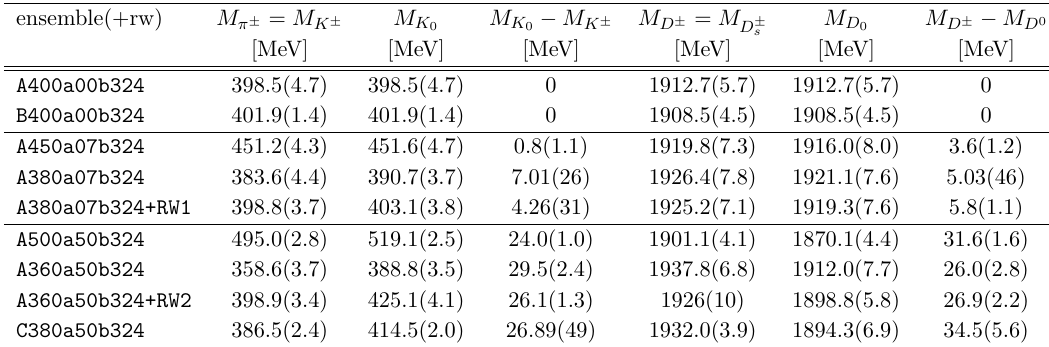
Table 5 . For each ensemble (possibly with mass reweighting): meson masses, and charged-neutral meson mass differences. Values in MeV are obtained by using the reference value (8 t 0 ) 1 / 2 = 0 . 415 fm [51]. Notice that some mesons are degenerate because in our simulations m d = m s .